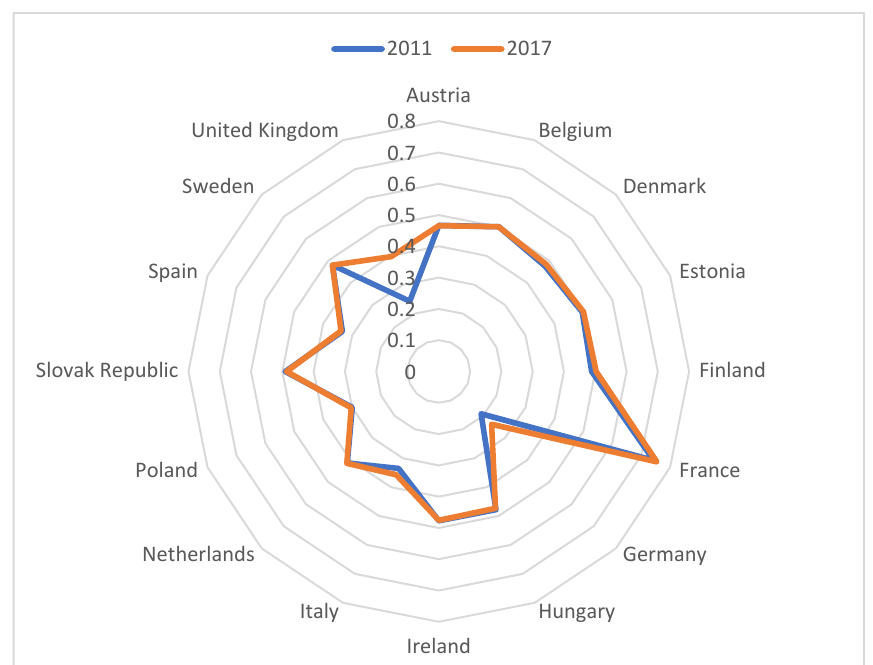
Figure 6. The average level of environmental performance of nuclear energy R&D (million USD and PPP) for selected EU countries in 2011 and 2017.